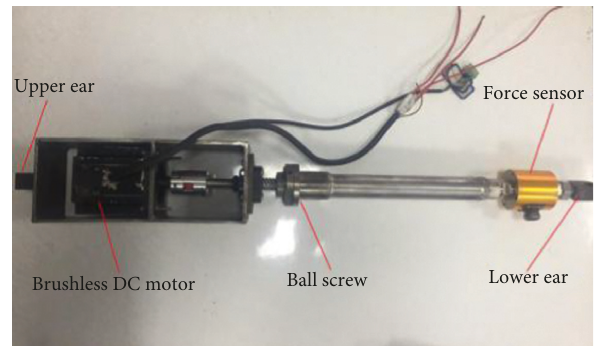
Figure 5: The ball screw